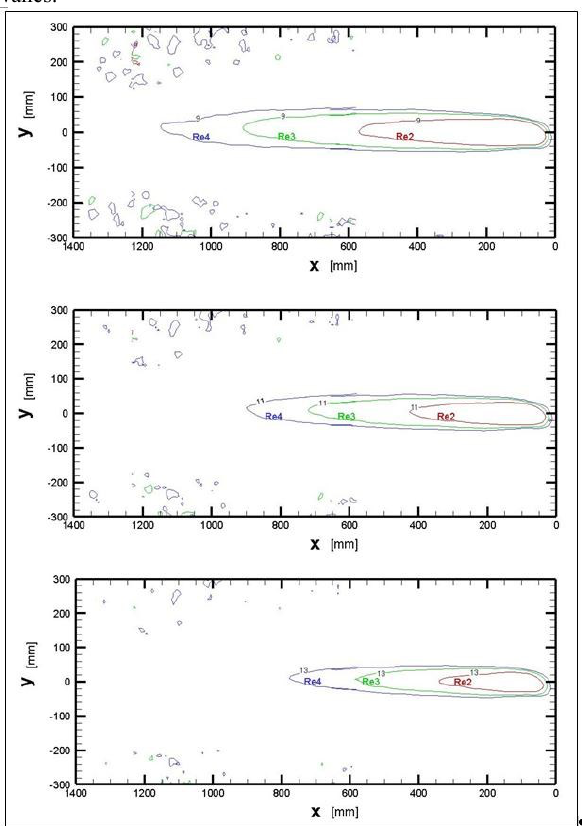
Fig. 6 . The lines with the same value velocity vector axial component Vx at the air flow rate 385m3/h and for the 75 angle